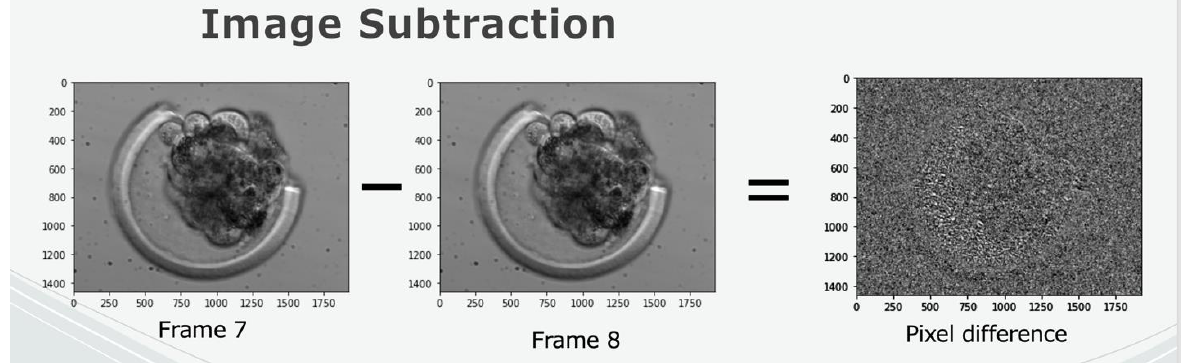
Figure 4. Subsequent frames are subtracted from each other. If there is no difference in pixel color/gradient, the image will appear static without any contours/artifacts or remnants of the image. If there is a difference, a ghostly figure will appear which can be quantified. Image collected from TE-300 inverted microscope, 400×.